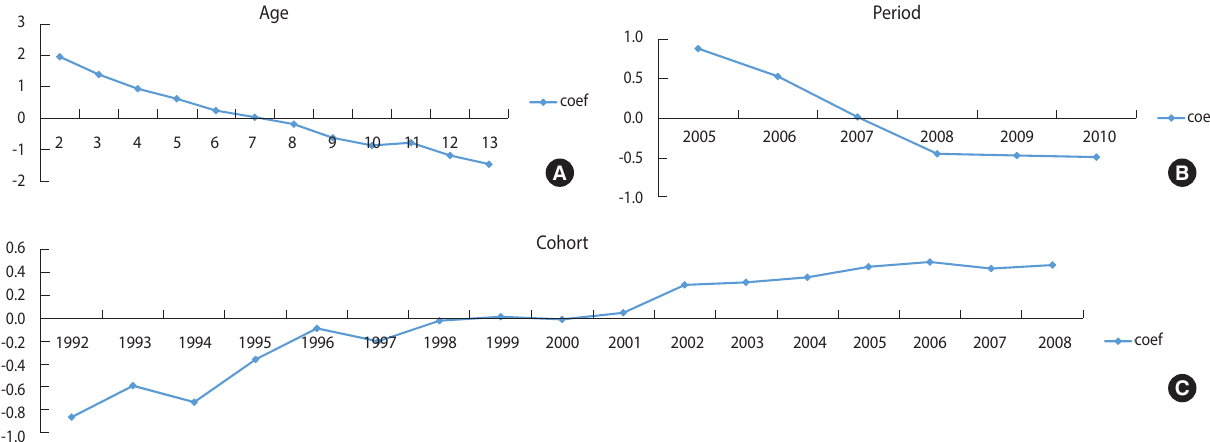
Figure 3. Intrinsic estimator (coef) of age (A), period (B), cohort (C) effect from annual age-specific crude incidence rates (1,000 person) of varicella by age (2-13 years old) and calendar year (2005-2010) in children in Jeju-do, Republic of Korea.